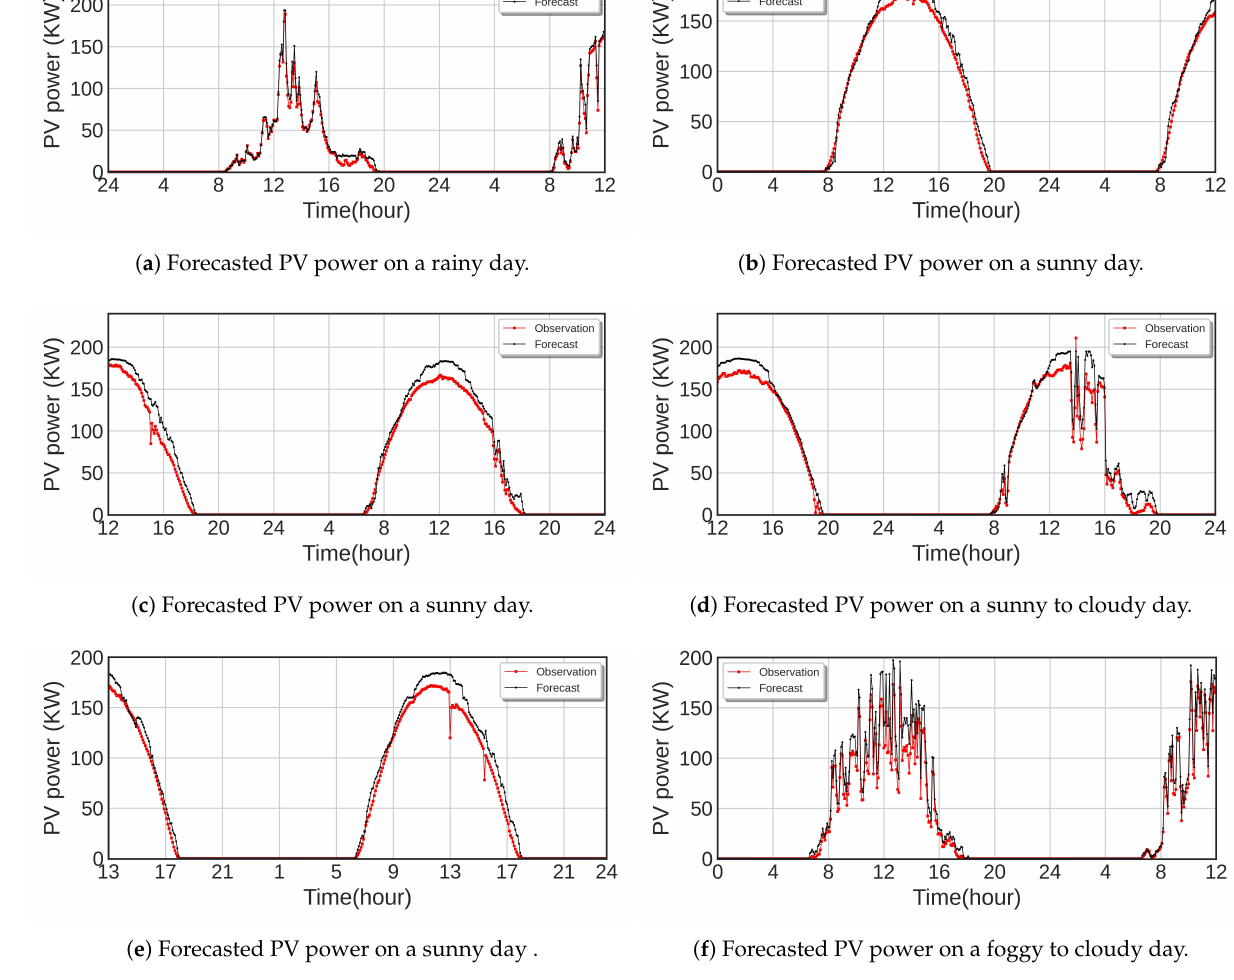
Figure 10. Actual and forecasted PV power using DKASC dataset for different weather patterns with ( a ) March 20, Rainy. ( b ) May 20, sunny. ( c ) June 20, sunny. ( d ) July 20, sunny to cloudy. ( e ) September 20, Sunny. ( f ) November 20, foggy to